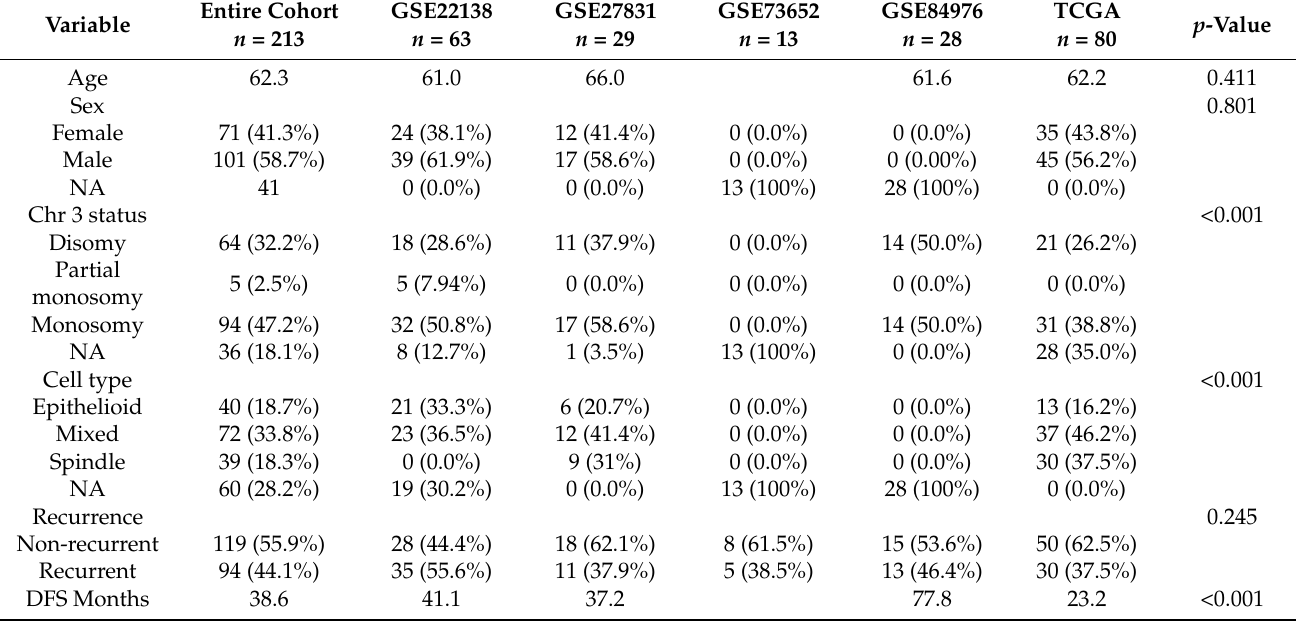
Table 1. Baseline characteristics of samples included in the analysis by dataset. p -values for categorical variables indicate results from Chi-Squared Tests. p -values for continuous variables indicate results from Kruskal tests. DFS: disease-free